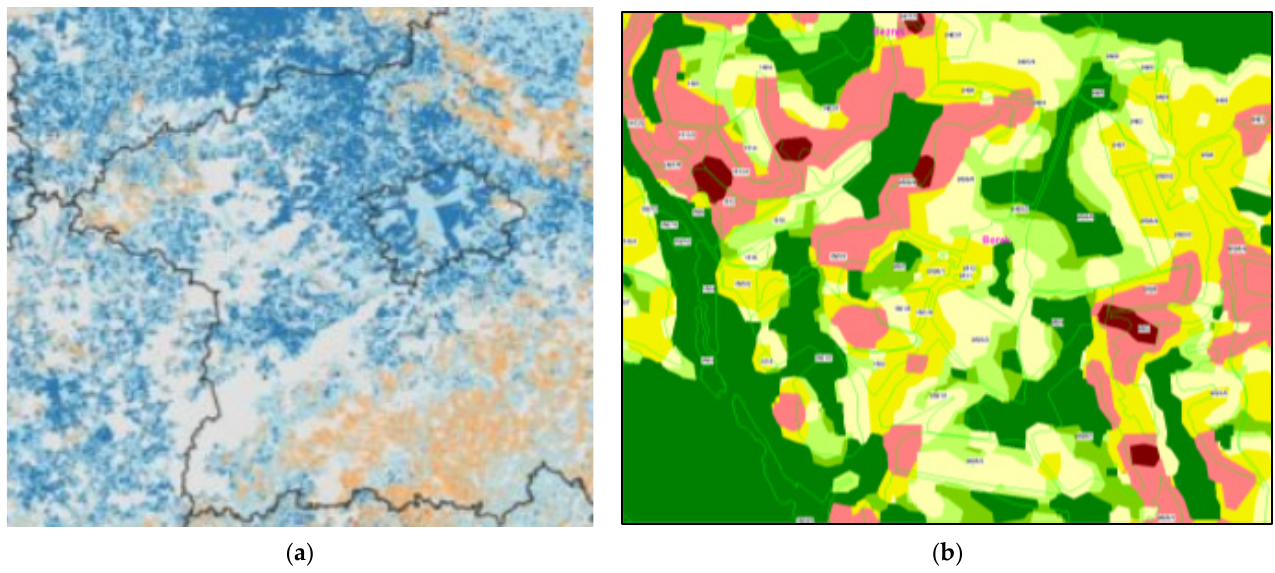
Figure 1. ( a ) Example of the Czech Republic’s approach to the field-scale mapping of the potential loss of soil organic matter levels. Gradient: dark grey—no potential risk; yellow—moderate potential risk; red—greatest potential risk. ( b ) Example of the Czech Republic ‘s approach to the field-scale mapping of risk regarding soil organic matter levels because of erosion effects. Gradient: green, yellow—no potential erodibility; pink—moderate erodibility; red—severe erodibility. Source: Portál farmá ř e—Nový iLPIS, Sitewell s.r.o., 2010.